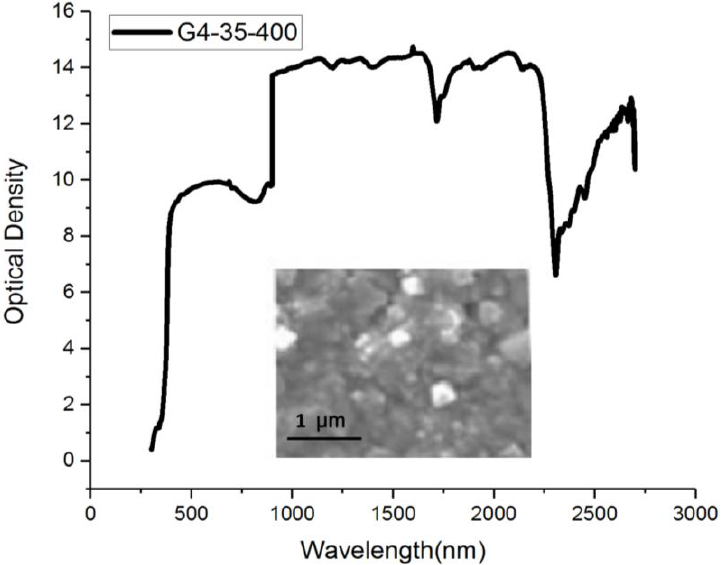
Figure 6. Proportions of individual elements of di ff erent CIGS films in the wavelength distribution of the optical spectrum (G4-35-400).